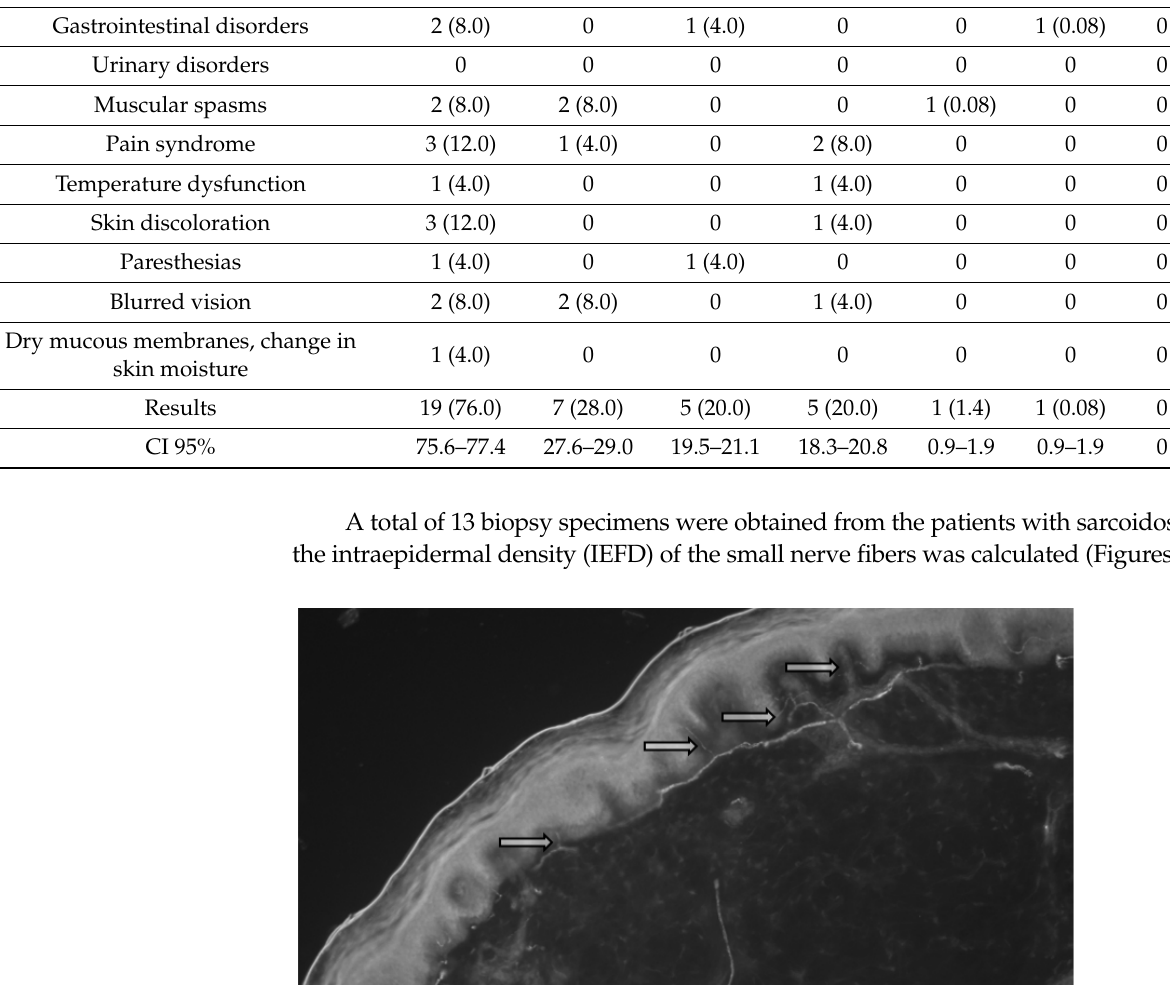
Figure 1. Skin biopsy of patient with sarcoidosis (enzyme immunoassay, male, 34 years). Arrows indicate small fibers in the epidermis of the skin.